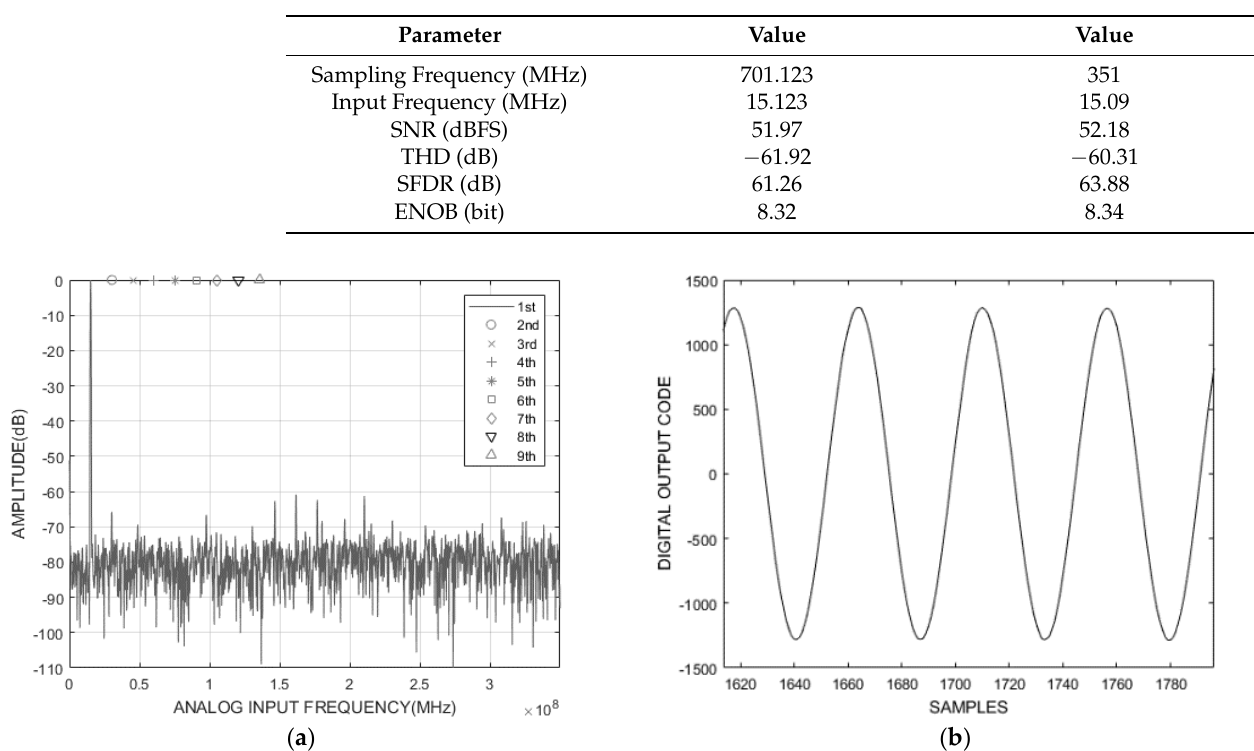
Table 7. Performance tables for actual testing.